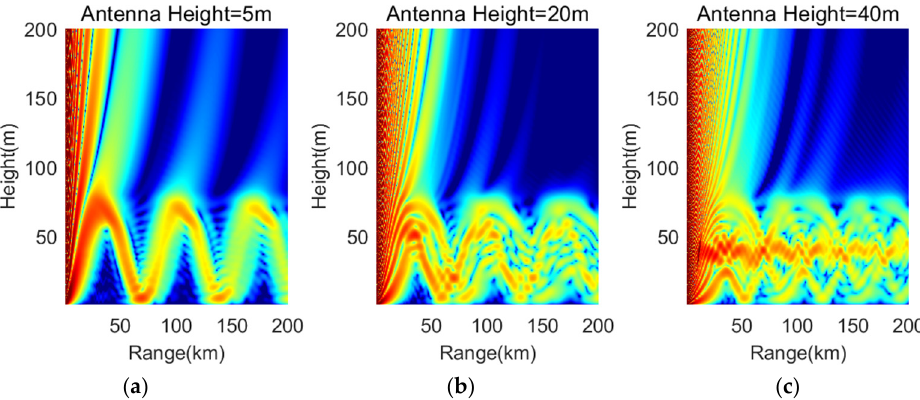
Figure 16. Path loss distributions for surface ducts with different antenna heights: ( a ) antenna height of 1 m, ( b ) antenna height of 20 m, and ( c ) antenna height of 40 m.